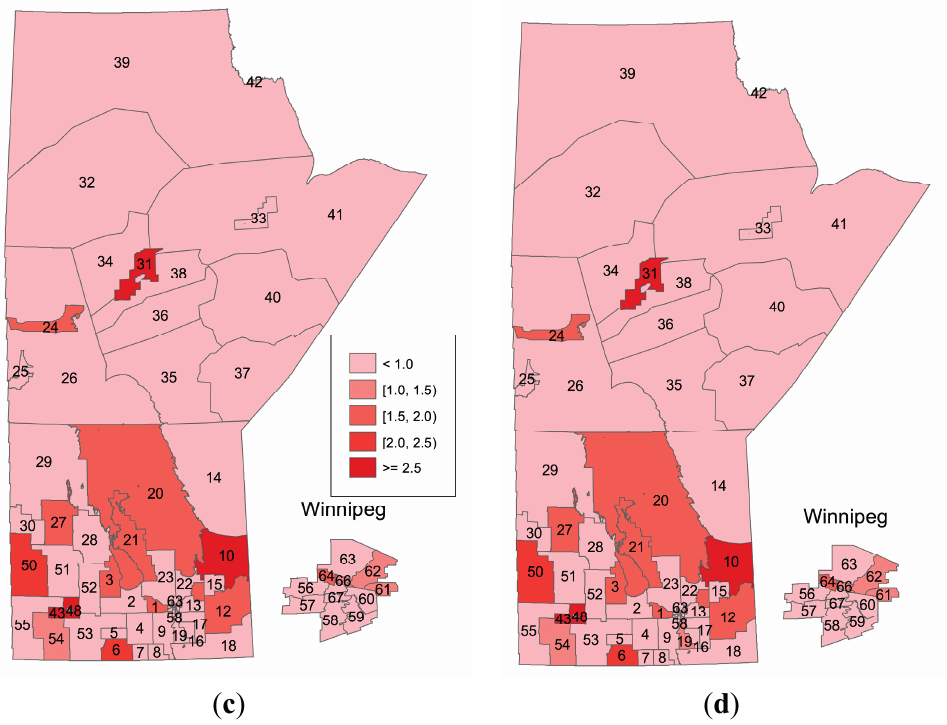
Figure 3. The order of most likely clusters of COPD for the CSS and FSS methods, and the special effects of the regional COPD risks for the BYM and MLE methods; in the case of cluster C. Major urban centre (Winnipeg region) is incorporated as an inset. ( a ) CSS; ( b ) FSS; ( c ) BYM; ( d )